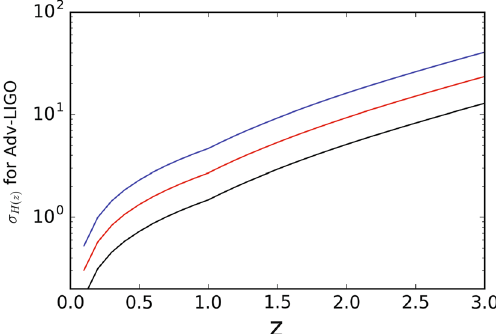
Fig. 7 Same asFig. 5, but for aLIGO. Fora given observation time,the dash line and the solid line overlaps, because the lens error is relatively small compared with the instrument error of